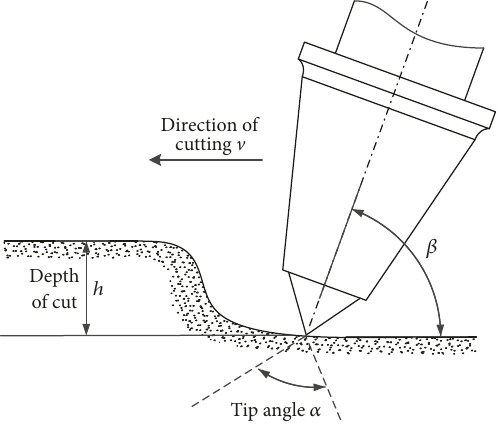
Figure 1: The cutting parameters of point attack